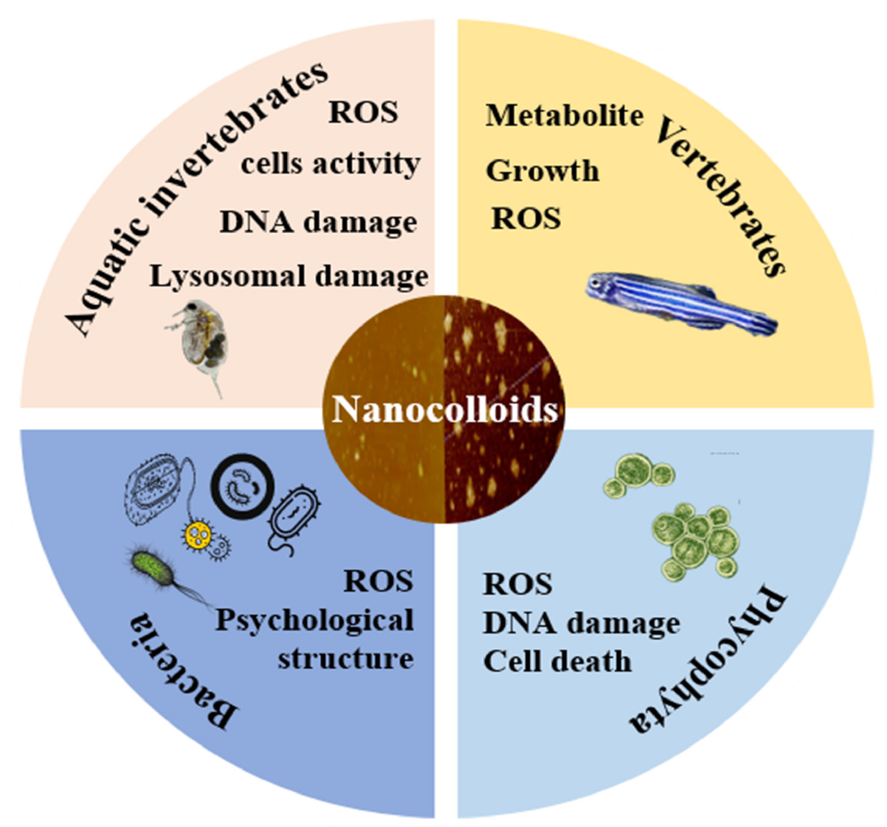
Figure 2. Toxicity of natural Ncs towards different aquatic organism.